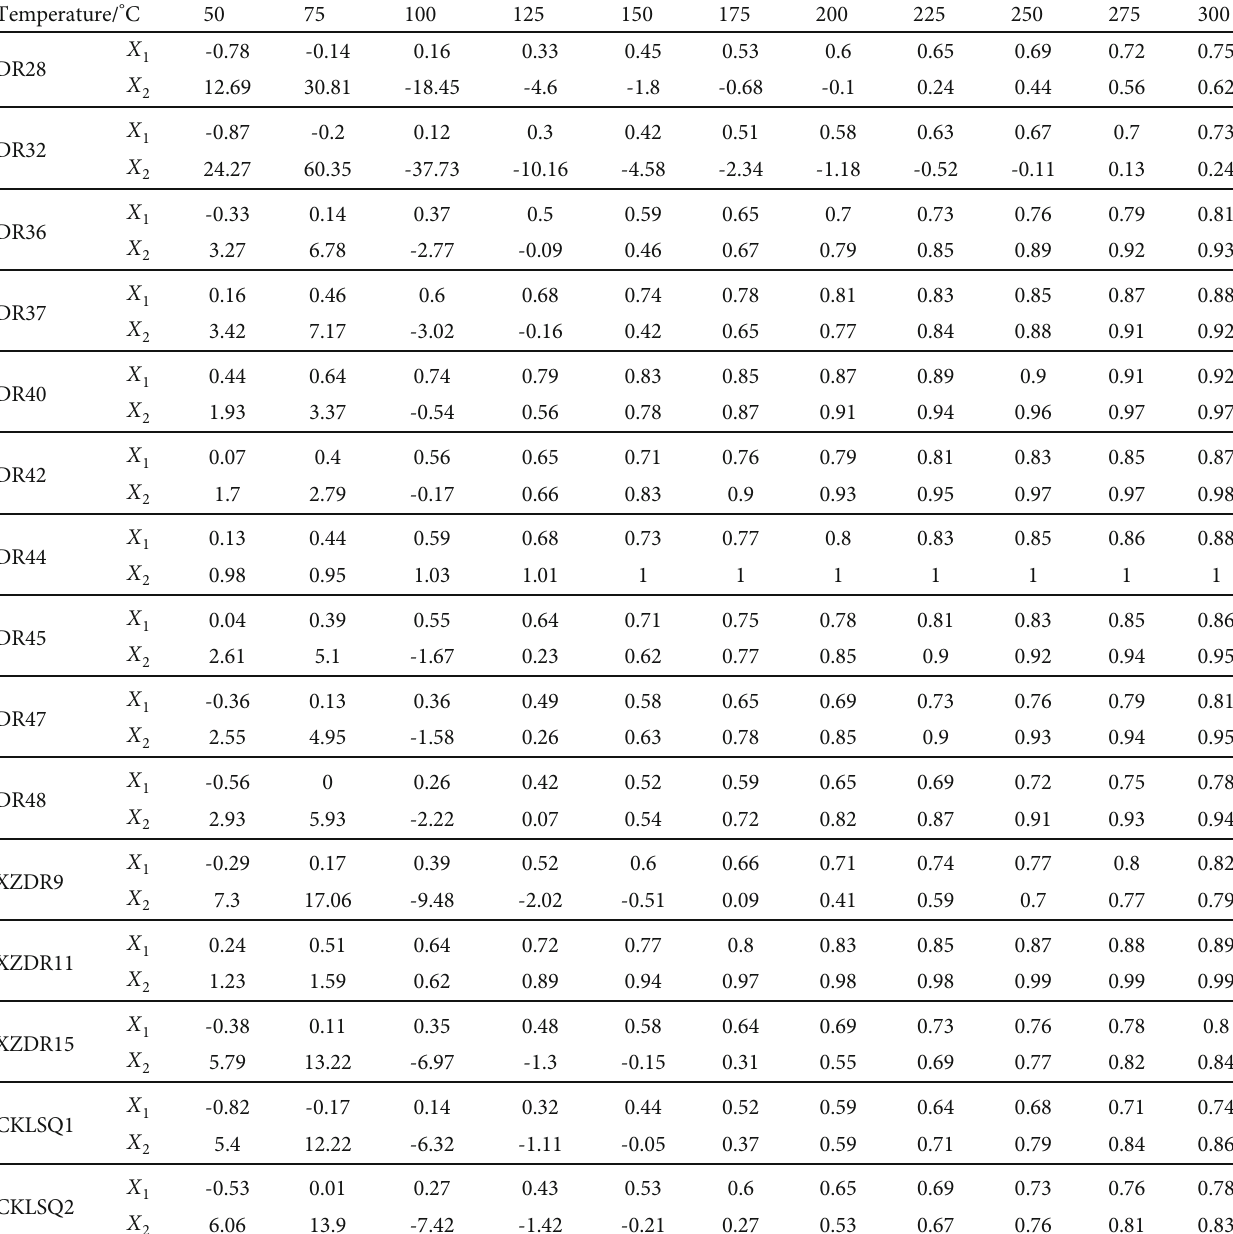
and X hot springs in the study area. 1 2